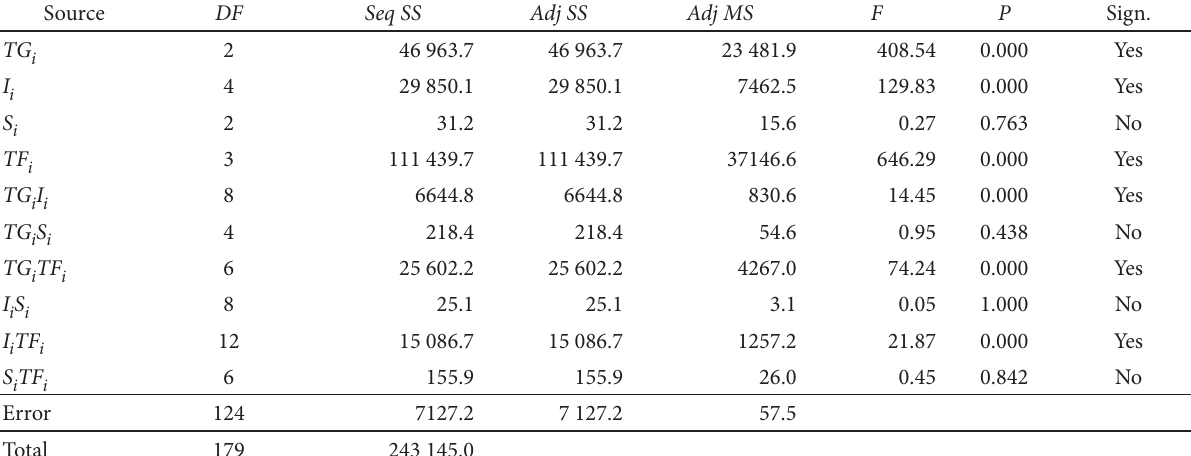
Fig. 4. Interaction plots for stop-line delays in R -scenarios Table 4. Anova for stop-line delays in I -scenarios Source